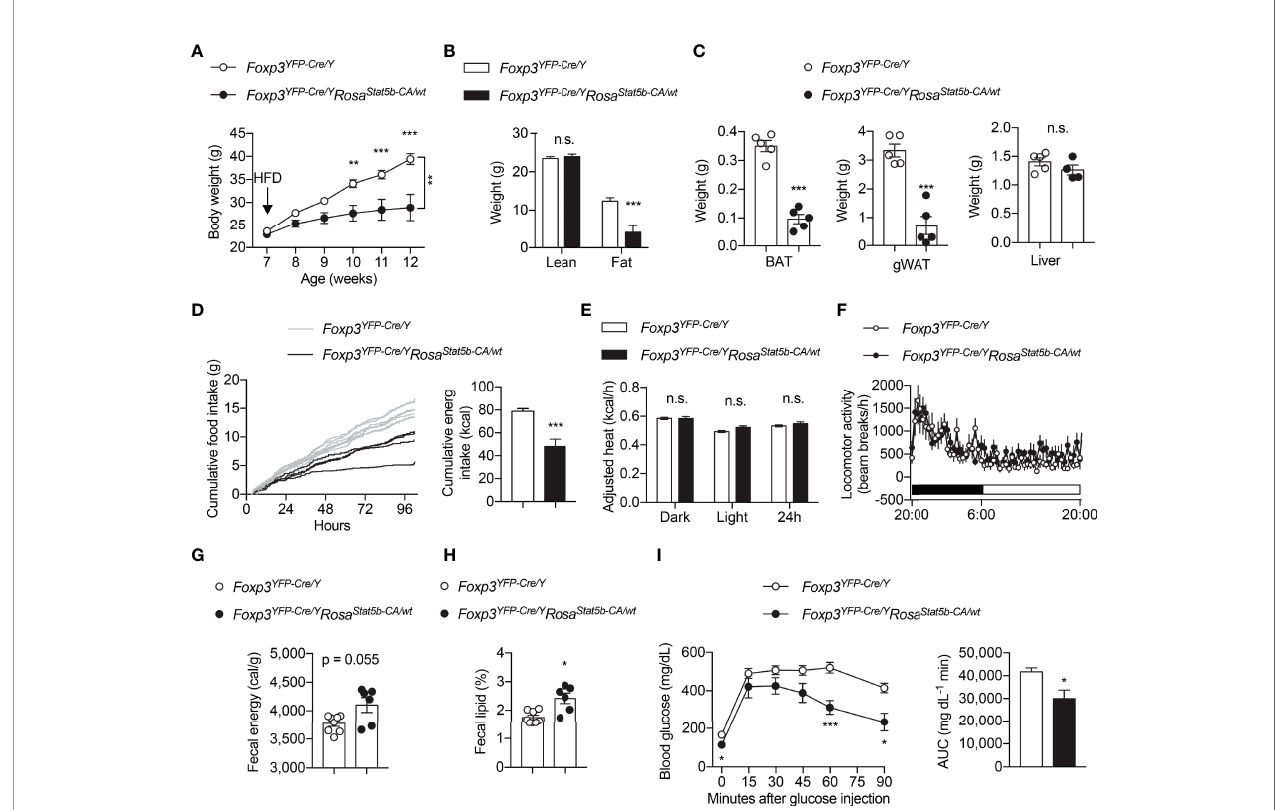
FIGURE 4 | Protection of Foxp3 YFP-Cre/Y Rosa26 Stat5b-CA/wt mice from diet-induced obesity. (A) Body weight of Foxp3 YFP-Cre/Y (n = 9) and Foxp3 YFP-Cre/ Y Rosa26 Stat5b-CA/wt (n = 6) mice after HFD feeding. (B) Lean and fat mass of HFD-fed Foxp3 YFP-Cre/Y (n = 9) and Foxp3 YFP-Cre/Y Rosa26 Stat5b-CA/wt (n = 6) mice. (C) Weight of BAT, gonadal WAT, and liver of HFD-fed Foxp3 YFP-Cre/Y (n = 5) and Foxp3 YFP-Cre/Y Rosa26 Stat5b-CA/wt (n = 5) mice. (D) Cumulative food intake of Foxp3 YFP- Cre/Y (n = 7) and Foxp3 YFP-Cre/Y Rosa26 Stat5b-CA/wt (n = 4) mice when switched to HFD feeding. (E) Body weight-adjusted heat production and (F) locomotor activity of HFD-fed Foxp3 YFP-Cre/Y (n = 11) and Foxp3 YFP-Cre/Y Rosa26 Stat5b-CA/wt (n = 6) mice, determined by metabolic cages. (G) Fecal energy and (H) fecal lipid percentage of HFD-fed Foxp3 YFP-Cre/Y (n = 8) and Foxp3 YFP-Cre/Y Rosa26 Stat5b-CA/wt (n = 6) mice. (I) Glucose tolerance test of HFD-fed Foxp3 YFP-Cre/Y (n = 9) and Foxp3 YFP-Cre/ Y Rosa26 Stat5b-CA/wt (n = 6) mice. Area under curve (AUC) is shown to the right. Data are presented as mean ± SEM. n.s., not signi fi cant; *, p < 0.05; **, p < 0.01; ***, p < 0.001 by unpaired student ’ s t-test or two-way ANOVA (A, I)